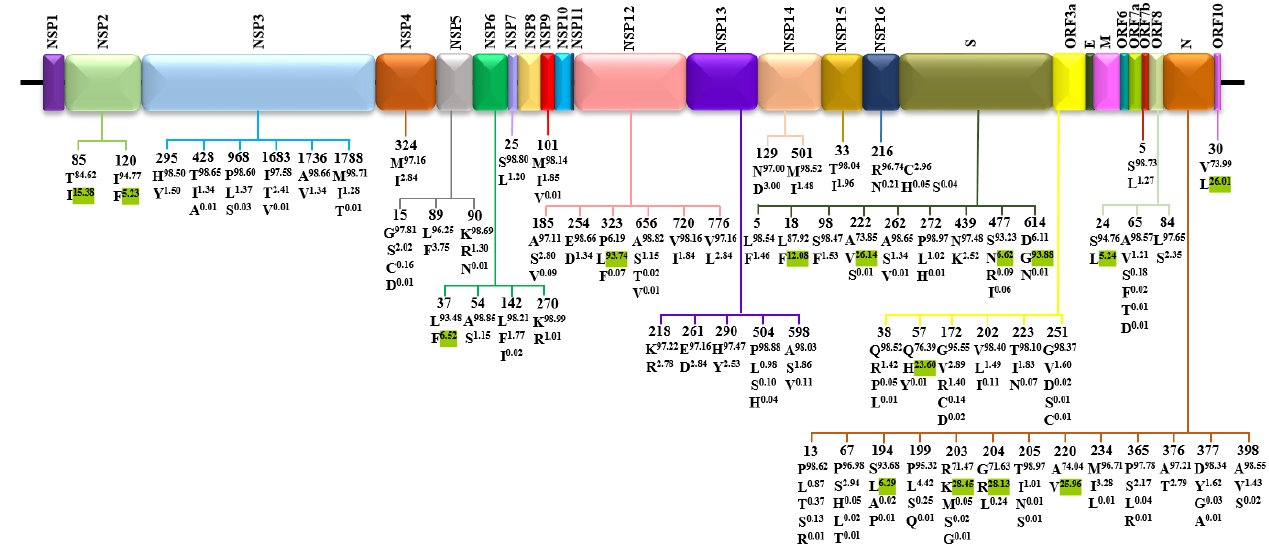
Figure 3. Distribution of variants at positions of SARS-CoV-2 proteins. For each site, the reference index is shown at the top, followed by variants with a frequency >1%. Variants highlighted with green superscripts were those with frequencies >5%.